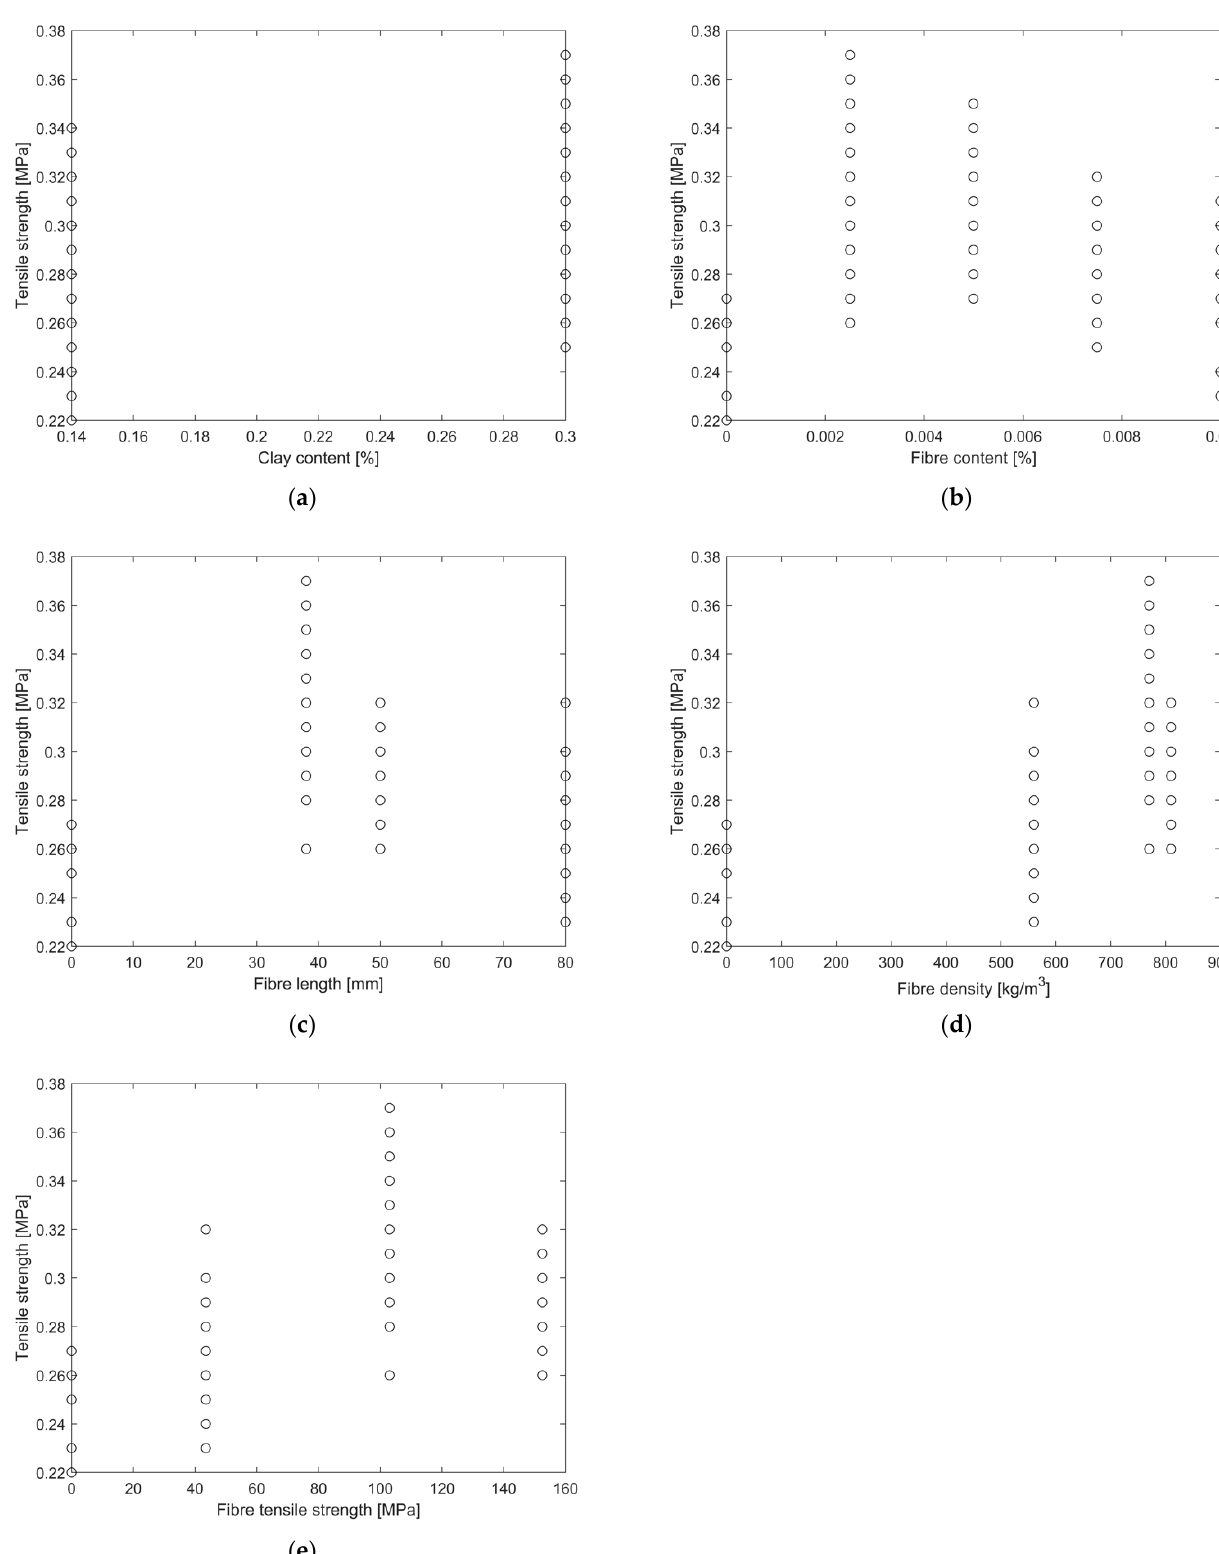
Figure 5. Relationship between each of the features of Database 2 (clay content ( a ), fibre content ( b ), fibre length ( c ), fibre density ( d ) and fibre tensile strength ( e )) and the corresponding tensile strength values.